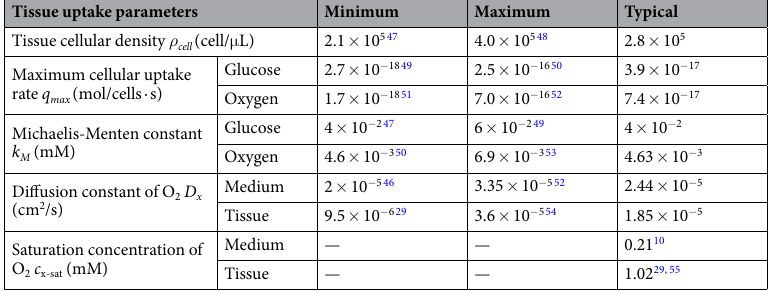
Table 1. Tissue uptake parameters found in literature for various cell types and the typical value used in the The variability of tissue uptake parameters (tissue cellular density – inverse of cell size –, uptake rate and Michaelis-Menten constant) in literature is presented in Table 1 for two nutrients essential to metabolism: glucose and oxygen. The typical parameter values are taken from EMT6/Ro which are a fully characterized cell type for uptake and diffusion parameters. These parameters are pertinent but not essential for a diffusion analysis because they can be estimated in a worst-case approximation. For a fluid dynamics analysis, the only tissue parameter that is required is tissue diameter d , as shown in Fig. 2B, which is known by the type of tissue being trapped. stant of PDMS (ranging from 3.25 × 10 − 5 cm 2 /s 27 to 7.88 × 10 − 5 cm 2 /s 29 ) is higher than that of water (ranging